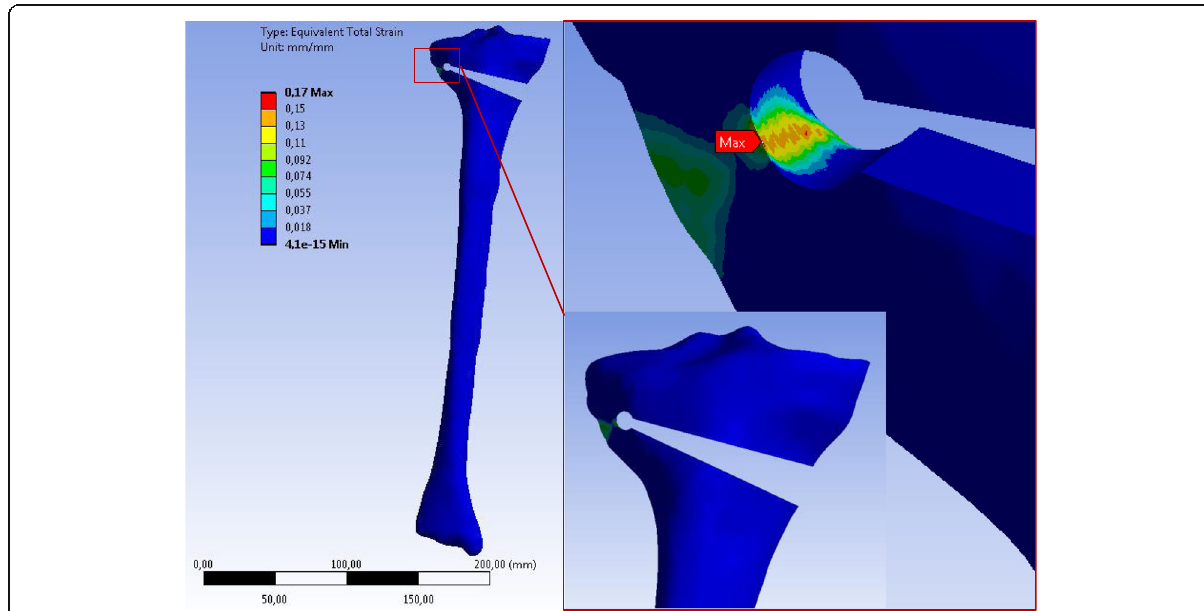
Fig. 17 Equivalent total strain (von-Mises) in the specimen SWHE for material case L: The total strain was calculated by nonlinear 3D FEA. The osteotomy gap is opened by 10°. The specimen has been slightly rotated in the enlargement